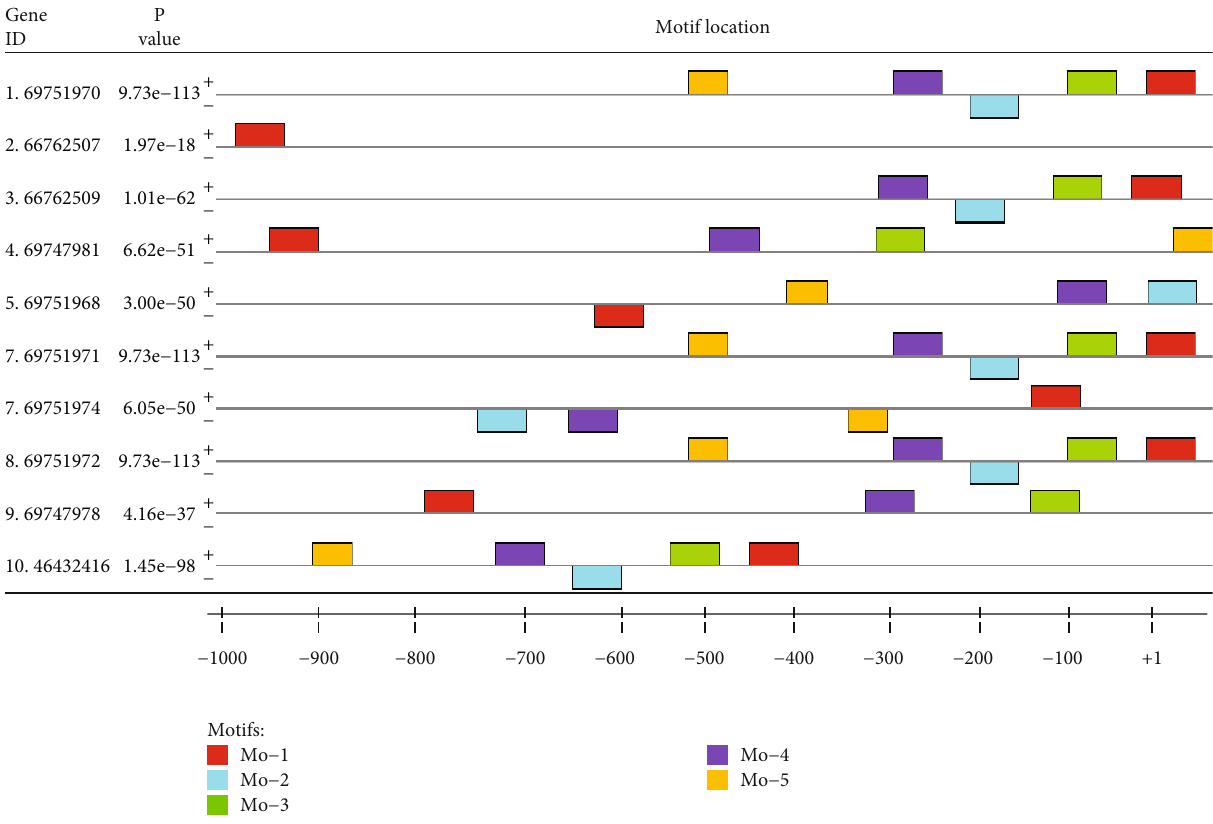
Figure 2: The relative locations of potential motifs in the promoter region relative to TSSs are illustrated in block diagrams. The nucleotide locations in the promoter region for mer genes encoding for mercury bioremediation are indicated at the bottom of the graph, ranging from +1 (start of TSSs) to upstream 1 kb (-1 kb) from MEME suite